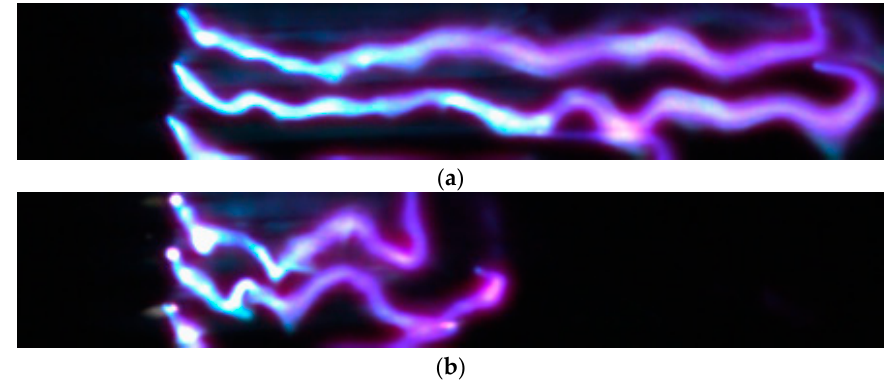
Figure 28. Discharge images at ( a ) weak combustion case and at ( b ) strong combustion with separation. Flow is from left to right. Exposure 1 µs, frame x-length is about 120 mm.